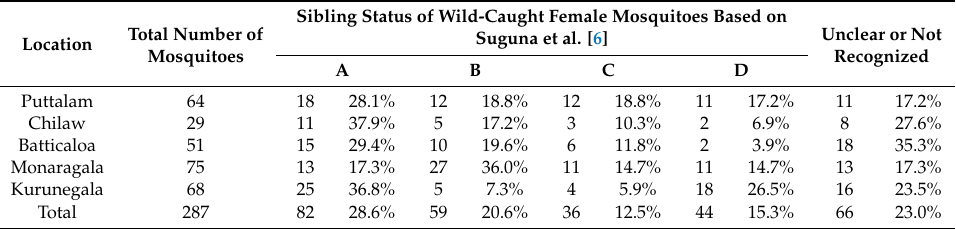
Table 2. Sibling species status of wild-caught female mosquitoes from sampling sites.